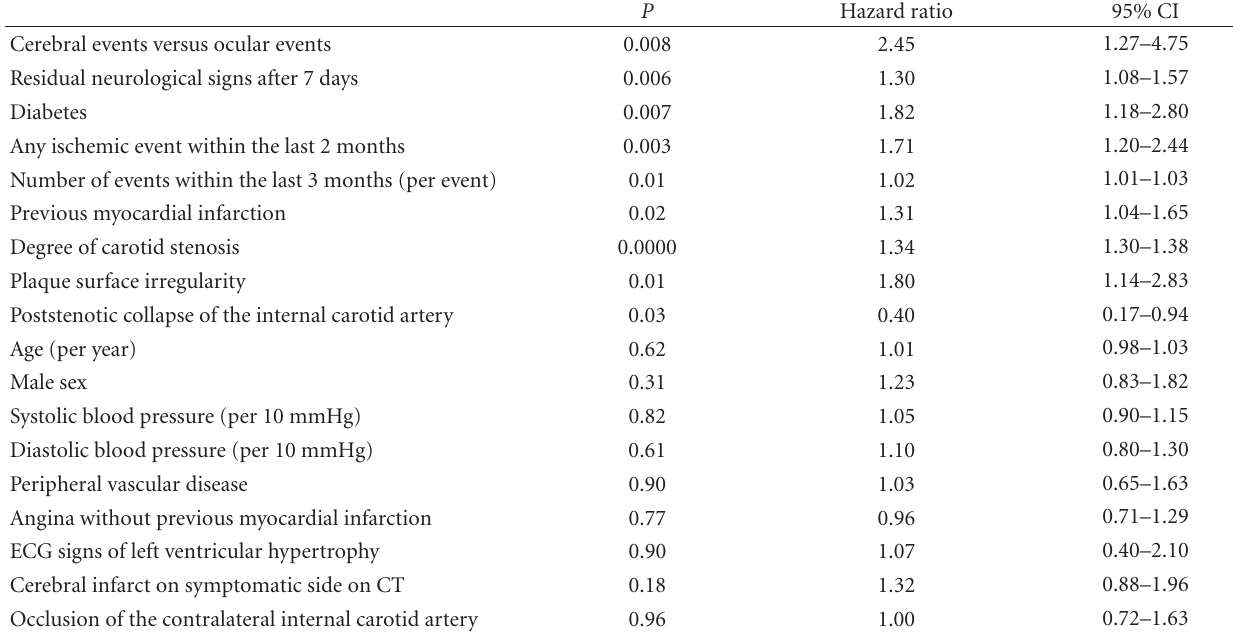
Table 4: Risk model by Rothwell for ipsilateral territorial infarcts in all patients in the medical treatment branch of ECST [61]. CI: confidence